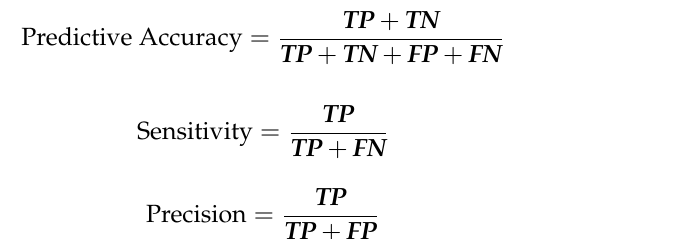
accuracy (Equation (1)), sensitivity (Equation (2)), and precision (Equation (3)) for the classification of the minority class were calculated.